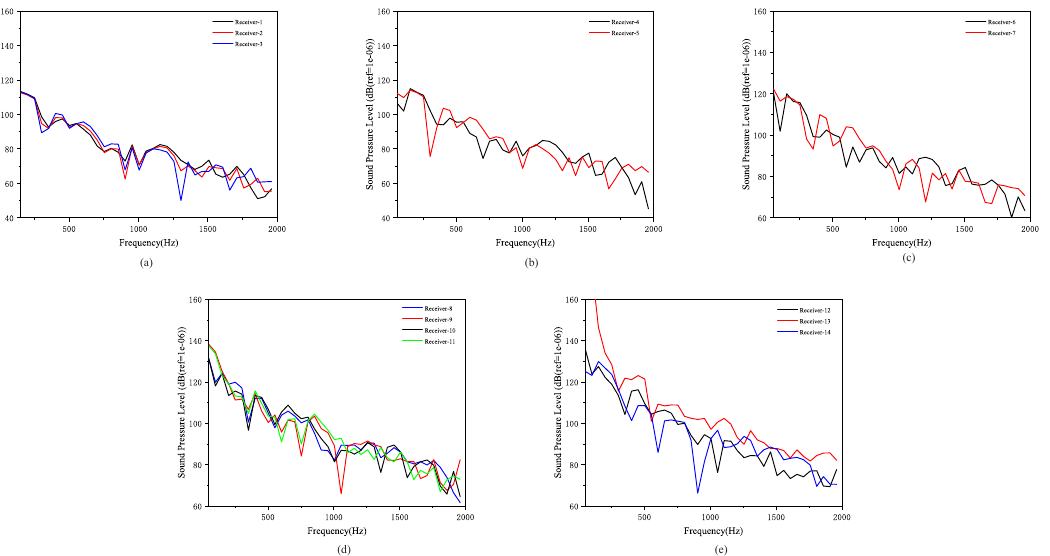
Figure 8. Spectral characteristics of sound pressure at different monitoring points along the flow direction considering Lighthill volume excition. ( a ) Receiver 1–3 ( b ) Receiver 4–6 ( c ) Receiver 6–7 ( d ) Receiver 8–11 ( e ) Receiver 12–14.